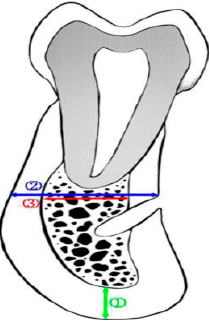
Figure 2. Paraxial view of the mental foramen in CBCT. ( 1 ) Thickness of the cortical bone in man- dibular inferior border. ( 2 ) Thickness of the total bone on the line parallel to the occlusal plane. ( 3 ) Thickness of the cancellous bone thickness on the line parallel to the occlusal